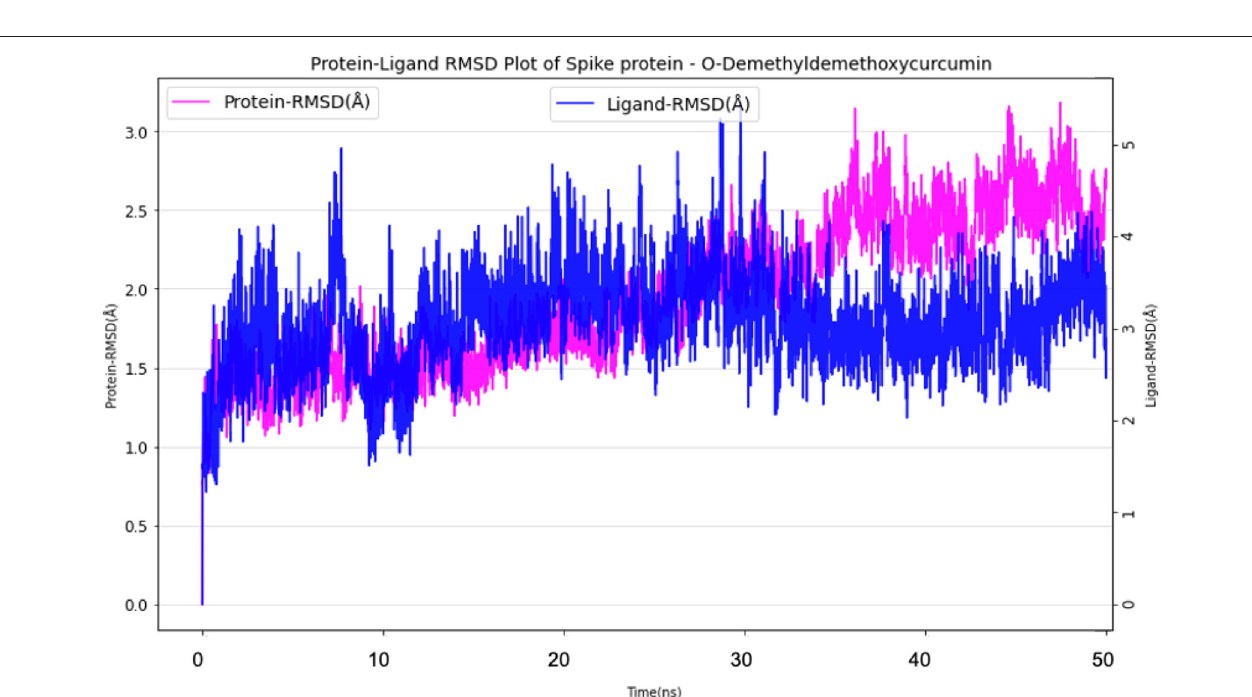
FIGURE 9 | Protein-Ligand RMSD plot of Spike protein O-Demethyldemethoxycurcumin complex.